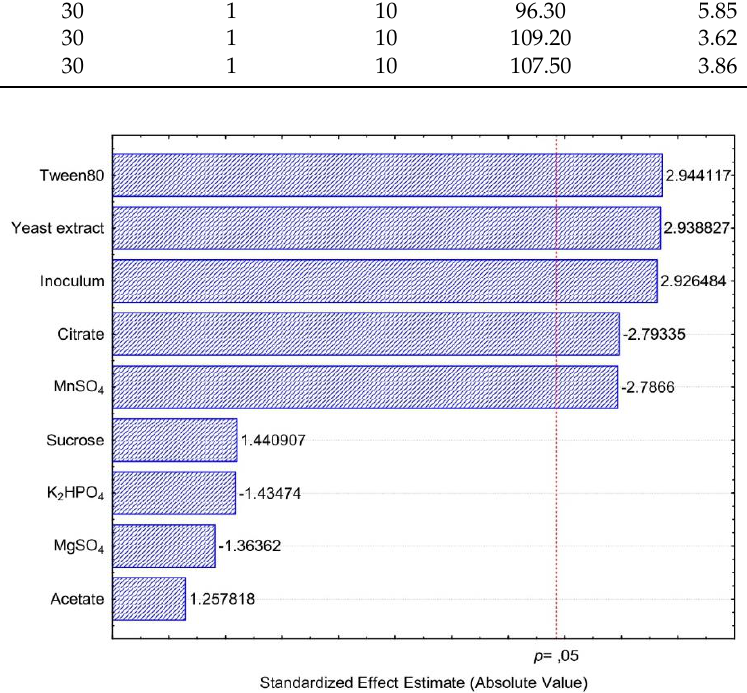
Figure 1. Pareto chart with standardized effect (t calc values) of variables studied in Plackett–Burman experimental design for production of lactic acid by Lactobacillus casei Ke11 after 24 h. Analyzing Table 4, the best lactic acid production was achieved in Experiment